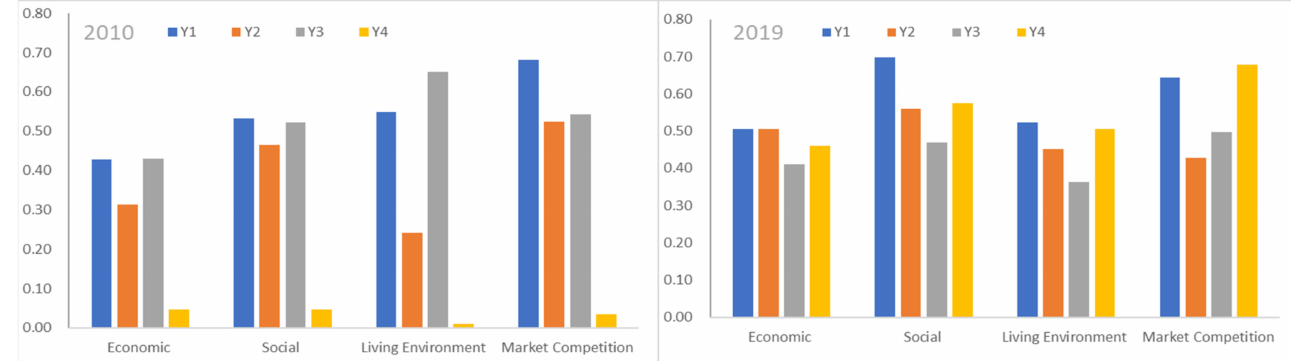
Figure 9. Analysis of driving